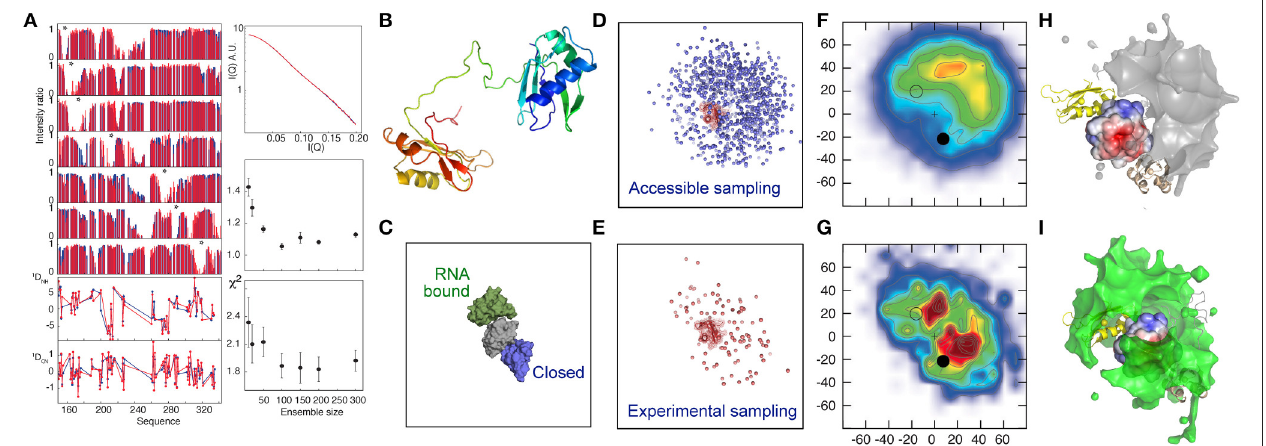
FIGURE 1 | Electrostatic interactions dominate the conformational equilibrium populated by the multi-domain splicing factor U2AF65. (A) Comparison between fitted (blue) and experimental (red) data. Upper left panel—PRE intensity ratios, lower-left panel, RDCs, top right panel SAXS, middle right panel active χ 2 , lower right panel cross validated χ 2 , both with respect to ensemble size. (B) Cartoon description of RRM1 and RRM2 domains, connected by the 32 amino-acid flexible linker. (C) Position of the previously determined closed (2YH0-blue) and open (2YH1-green) conformations of RRM1 relative to RRM2 (Mackereth et al., 2011). (D–I) Representation of the accessible (prior) conformational sampling of RRM2 compared to RRM1 on the basis of statistical coil sampling of the linker (D,F,H) and on the basis of experimental data (E,G,I) . (D,E) —Centre-of-mass representation, (F,G) —2D projections onto XY and XZ planes (in Å) with populations (derived from 100 Monte Carlo simulations; χ 2 /N ≈ 1, red/blue highly/weakly populated. “ + ” indicates center-of-mass of RRM1; closed and open circles 2YH0 and 2YH1, respectively, (H,I) —3D density maps (5% population contour showing the probability of the center of mass position averaged over the ensemble) of RRM2 distribution with respect to RRM1, showing occlusion of the acidic patch on the surface of RRM1 in the experimental distribution that is not present in the prior sampling, demonstrating that the experimental data require a redistribution of sampling. (Reprinted with permission from Huang et al., 2014. Copyright 2014 American Chemical